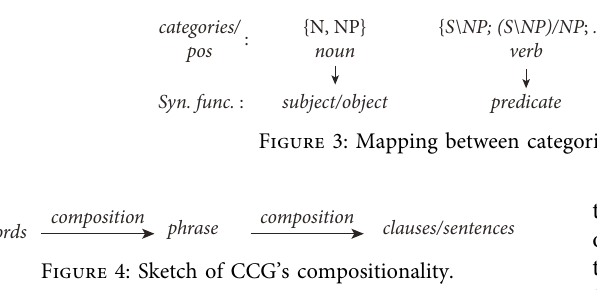
Figure 4: Sketch of CCG’s